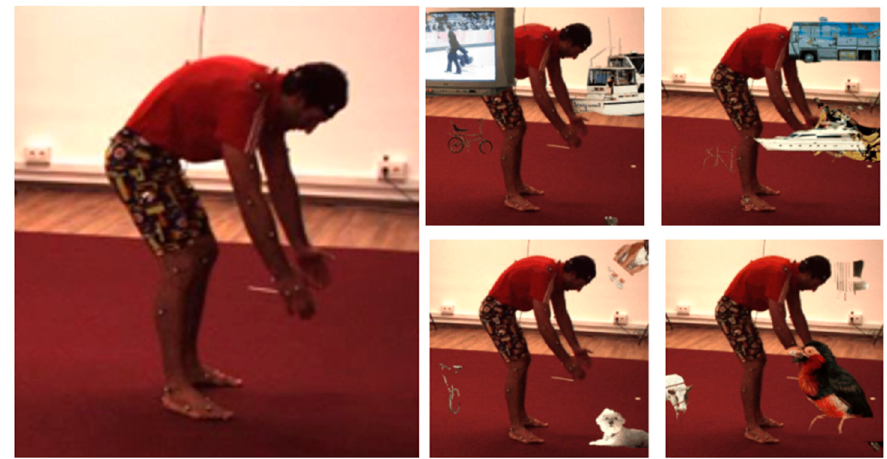
Figure 8. Occluded images from the Human3.6M dataset.